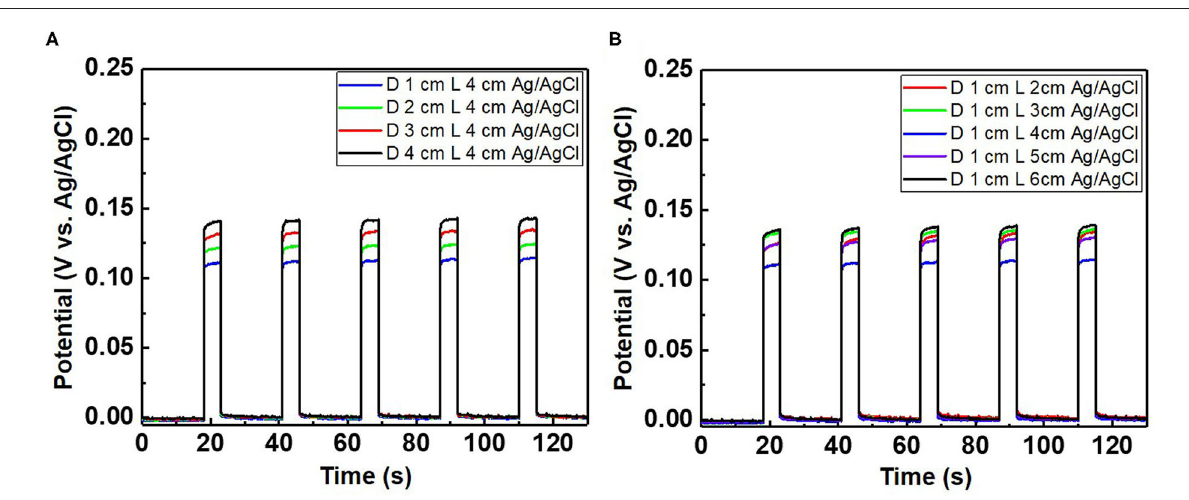
Frontiers in Chemistry | www.frontiersin.org